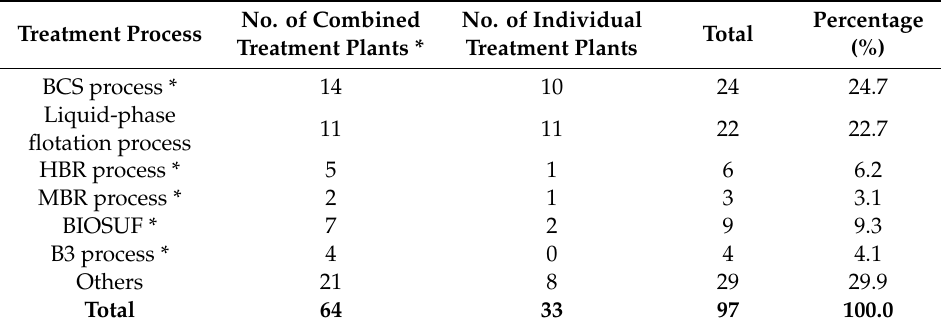
Table 2. Public livestock wastewater treatment plants in operation nationwide [23]. Treatment